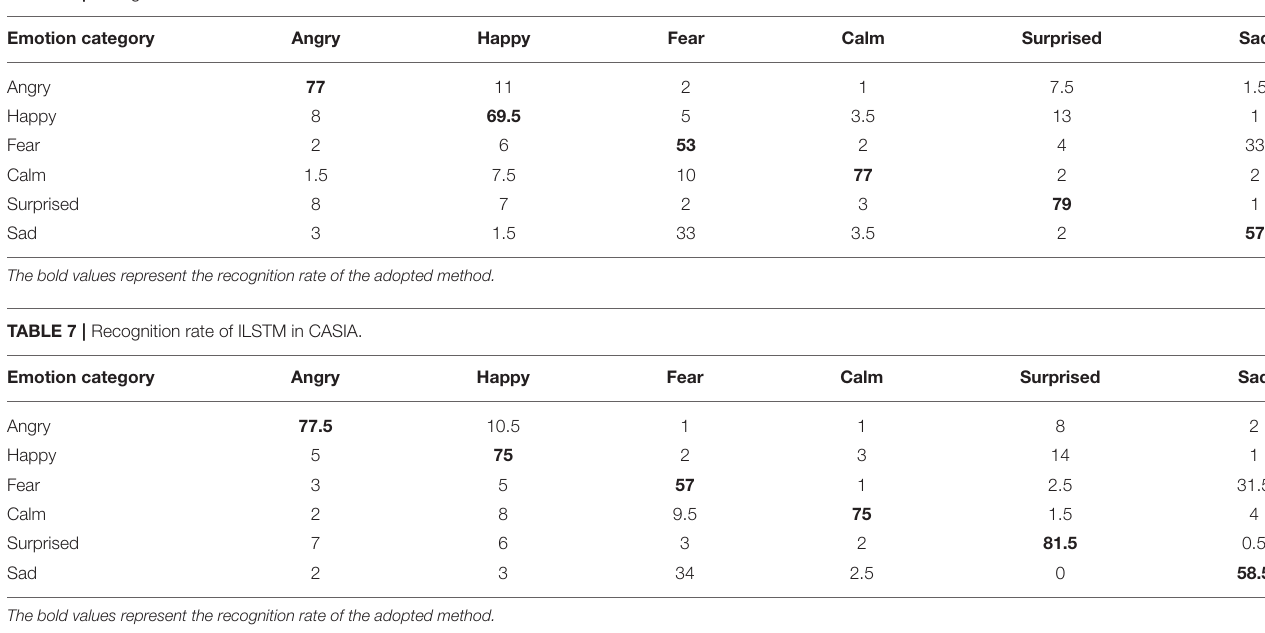
TABLE 6 | Recognition rate of traditional LSTM in CASIA. Emotion category